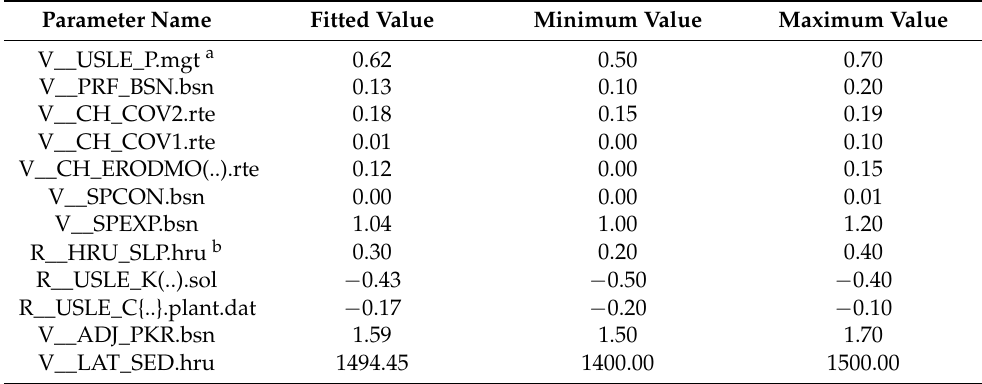
Table 2. Parameters used in TSS load auto-calibration using